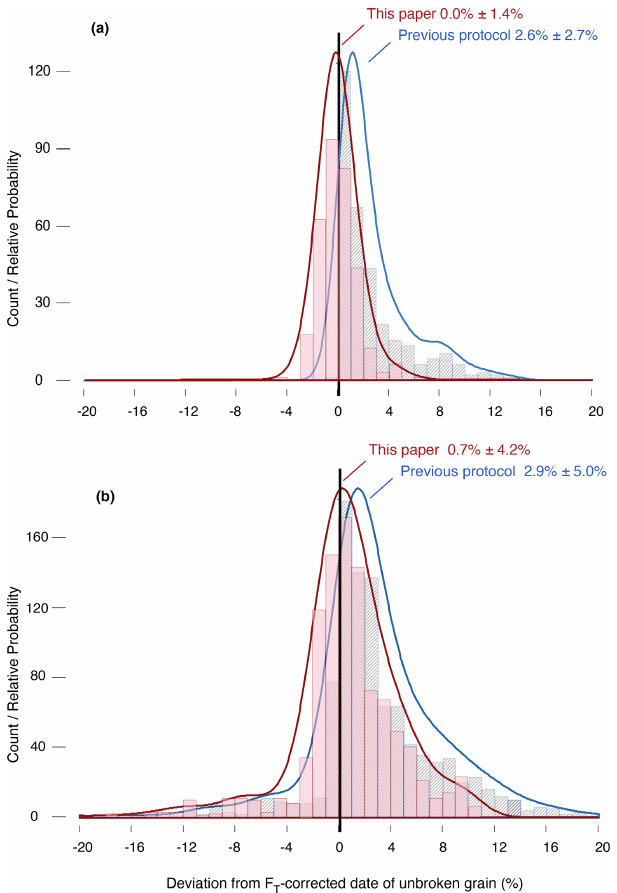
Figure 2. Histograms and kernel density estimate (KDE) functions comparing the results of applying the new protocol suggested in this paper (red) with the results of applying the previous protocol (blue) to a synthetic dataset of raw, uncorrected dates ( n = 1000, see Brown et al., 2013). The error is defined to be the % deviation of the F T -corrected dates of a broken crystal from the F T -corrected date of the whole crystal, which is known because the synthetic fragments are generated from a whole crystal with a known “age”. The new protocol is more accurate and more precise at correcting for the effect of fragmentation, both in the ideal case (a) assuming that fragmentation has occurred more than one average alpha stop- ping distance from the tip and that there is no significant diffusive modification of the helium profile, as well as in the more realistic scenario (b) , which includes corrected dates from fragments that are broken close to the tip and fragments that experienced thermal his- tories leading to significant diffusive modification in addition to the dates contained in (a) . Annotations show the mean ± standard devi- ation (1 σ ); KDE functions are normalized to the same peak